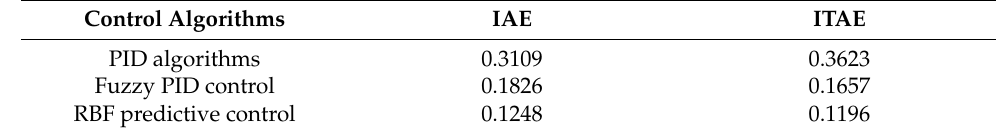
Table 3. Comparison of the performance of different controllers in the presence of interference